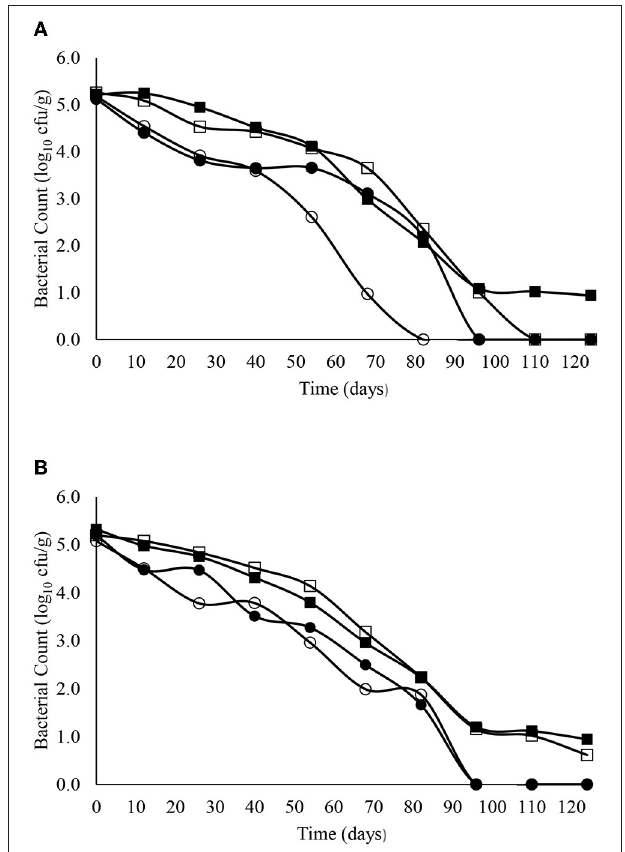
FIGURE 4 | The reduction in E. coli O157:H7 over time in sandy (A) and clay (B) soils including with slurry at 4 ◦ C ( (cid:4) ), digestate at 4 ◦ C ( (cid:3) ), slurry at 14 ◦ C ( • ) and digestate at 14 ◦ C (o).